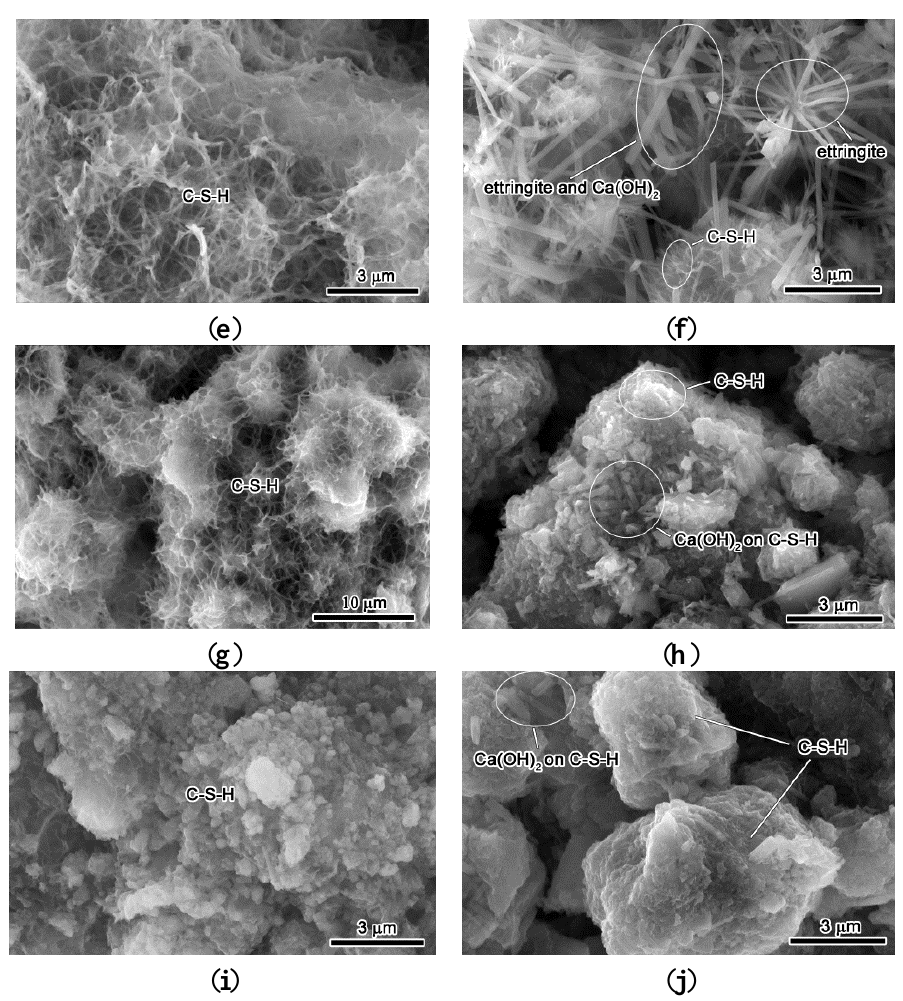
Figure 6. SEM observation of hydration process of RCP and OPC pastes at various ages. ( a ) RCP, 1 day; ( b ) OPC, 1 day; ( c ) RCP, 3 days; ( d ) OPC, 3 days; ( e ) RCP, 7 days; ( f ) OPC, 7 days; ( g ) RCP, 14 days; ( h ) OPC, 14 days; ( i ) RCP, 28 days; ( j ) OPC, 28 days.